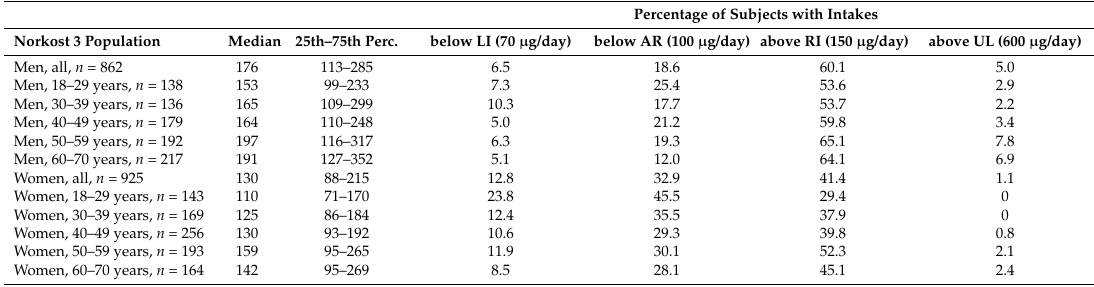
Percentage of Subjects with Intakes